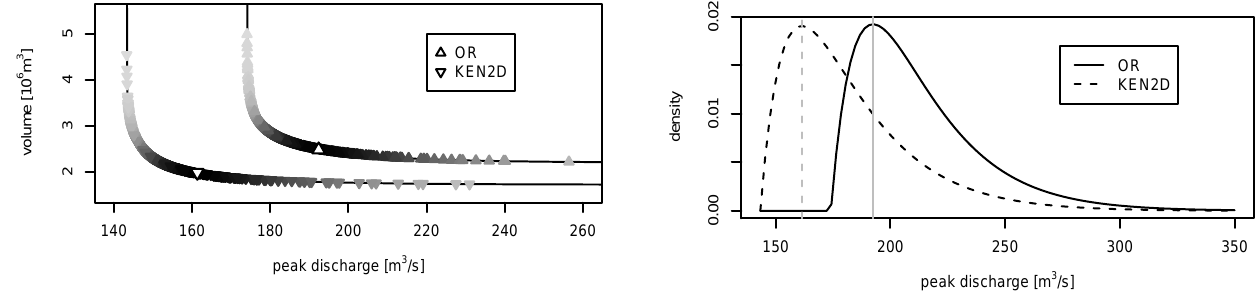
Fig. 7. An ensemble of 500 ( q p ,v p ) pairs that all have a copula- based and 2-D Kendall-based JRP of 10yr, respectively. The density of the ensemble is given in greyscale: the brighter the grey, the less events sampled. The most likely event is also indicated.